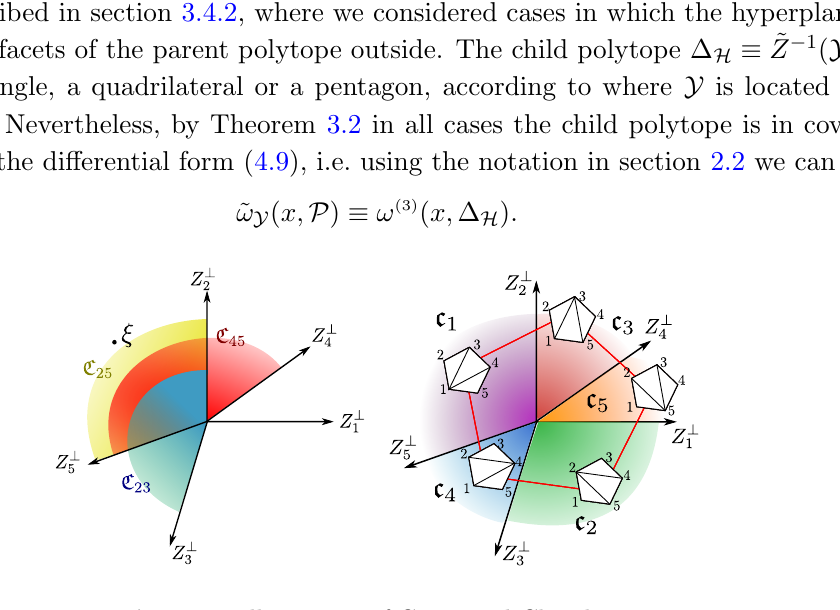
Figure 3 . Illustration of Cones and